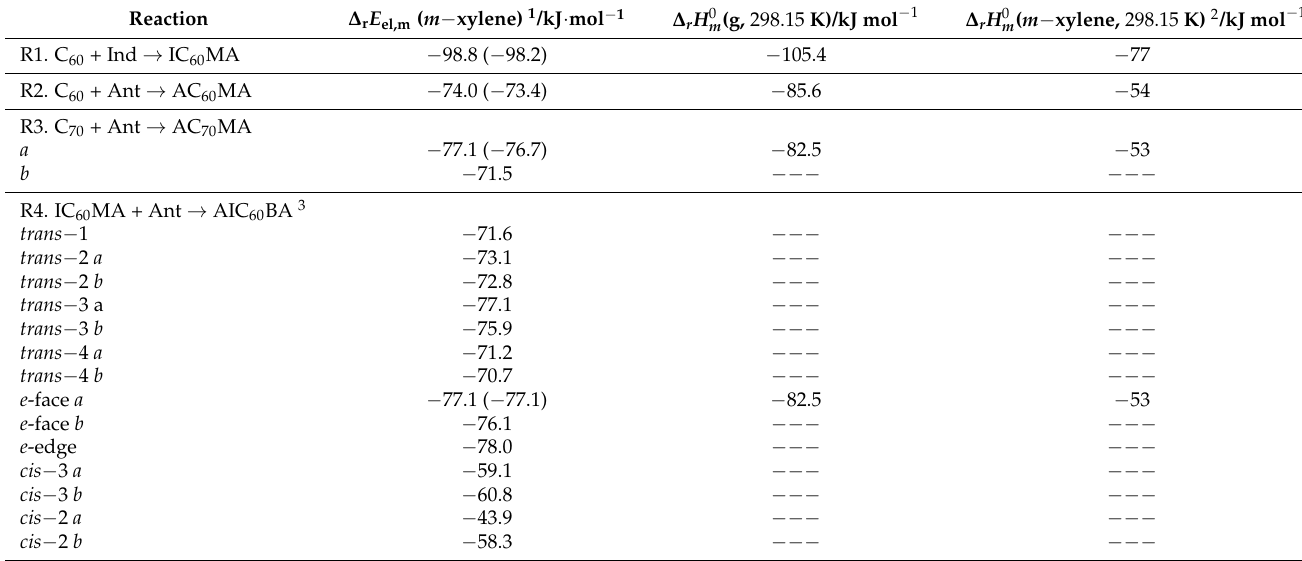
Table 4. Electronic energies of reaction in m − xylene, at T = 0 K, standard enthalpies of reaction in vacuum, at T = 298.15 K, and estimated standard enthalpies of reaction in m -xylene, at T = 298.15 K, for the Diels − Alder cycloadditions of the fullerenes studied with indene (Ind) and anthracene (Ant), calculated at the M06-2X/6-31+G(d) level of